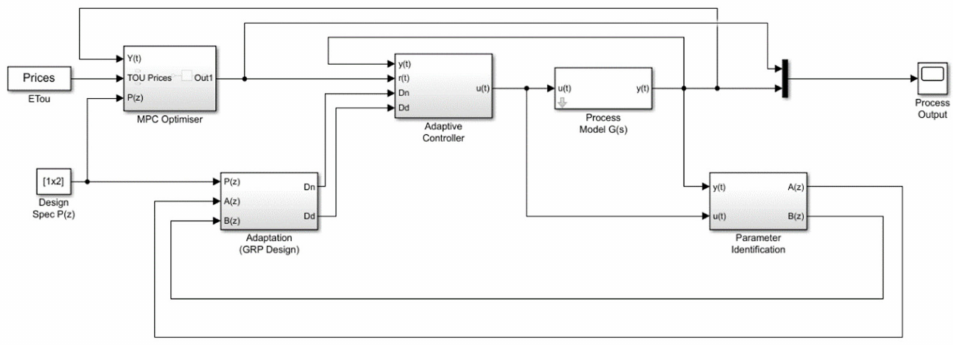
Figure 3. Simulink implementation of the supervisory control and optimisation scheme.